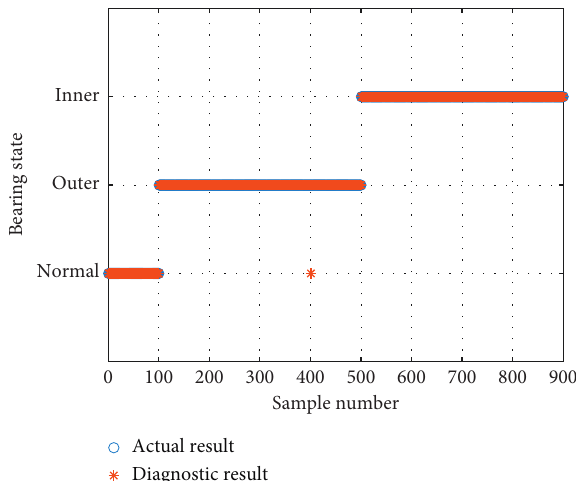
Figure 17: Fault diagnosis results of variable speed samples.